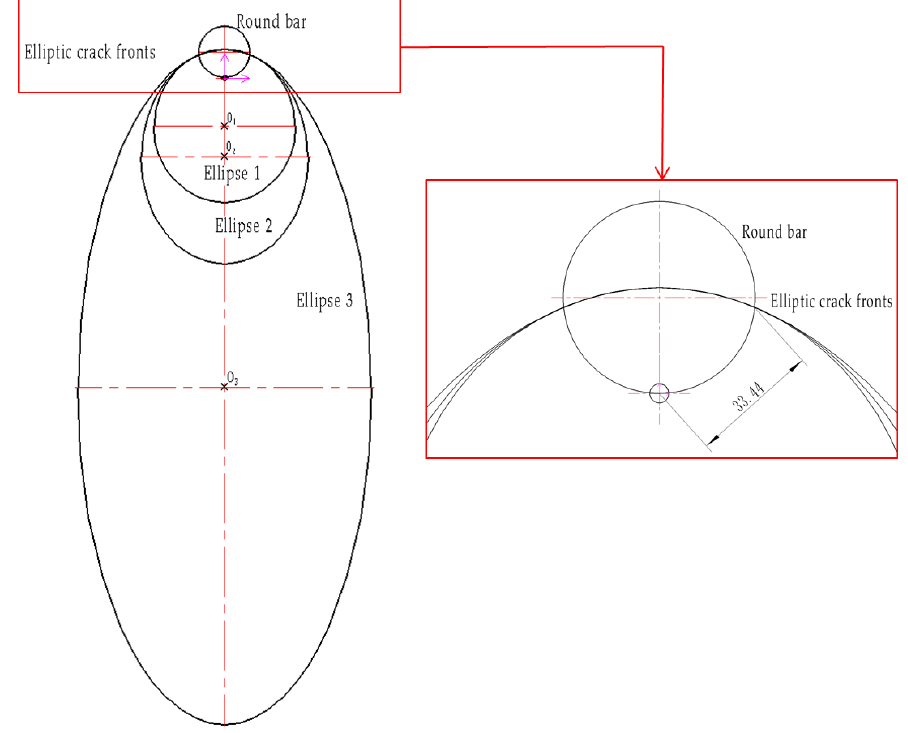
Figure 6. Crack front as a part of an ellipse.